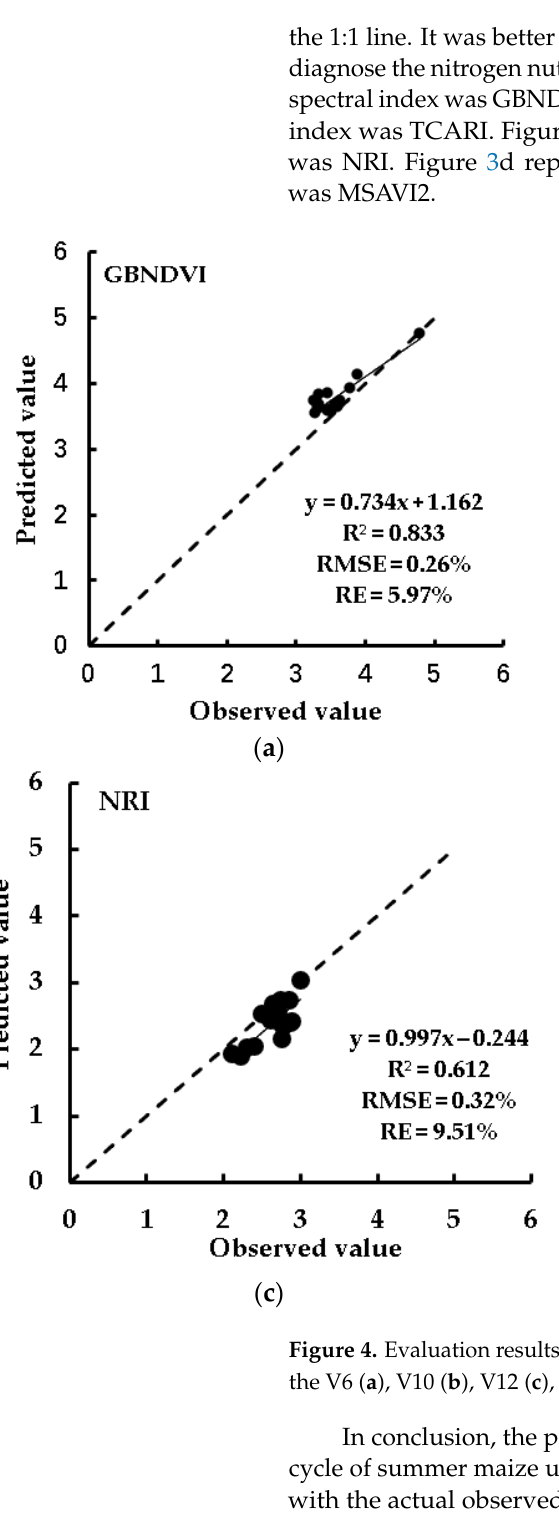
Table 6. A four-stage combined diagnostic model of nitrogen concentration in summer maize.